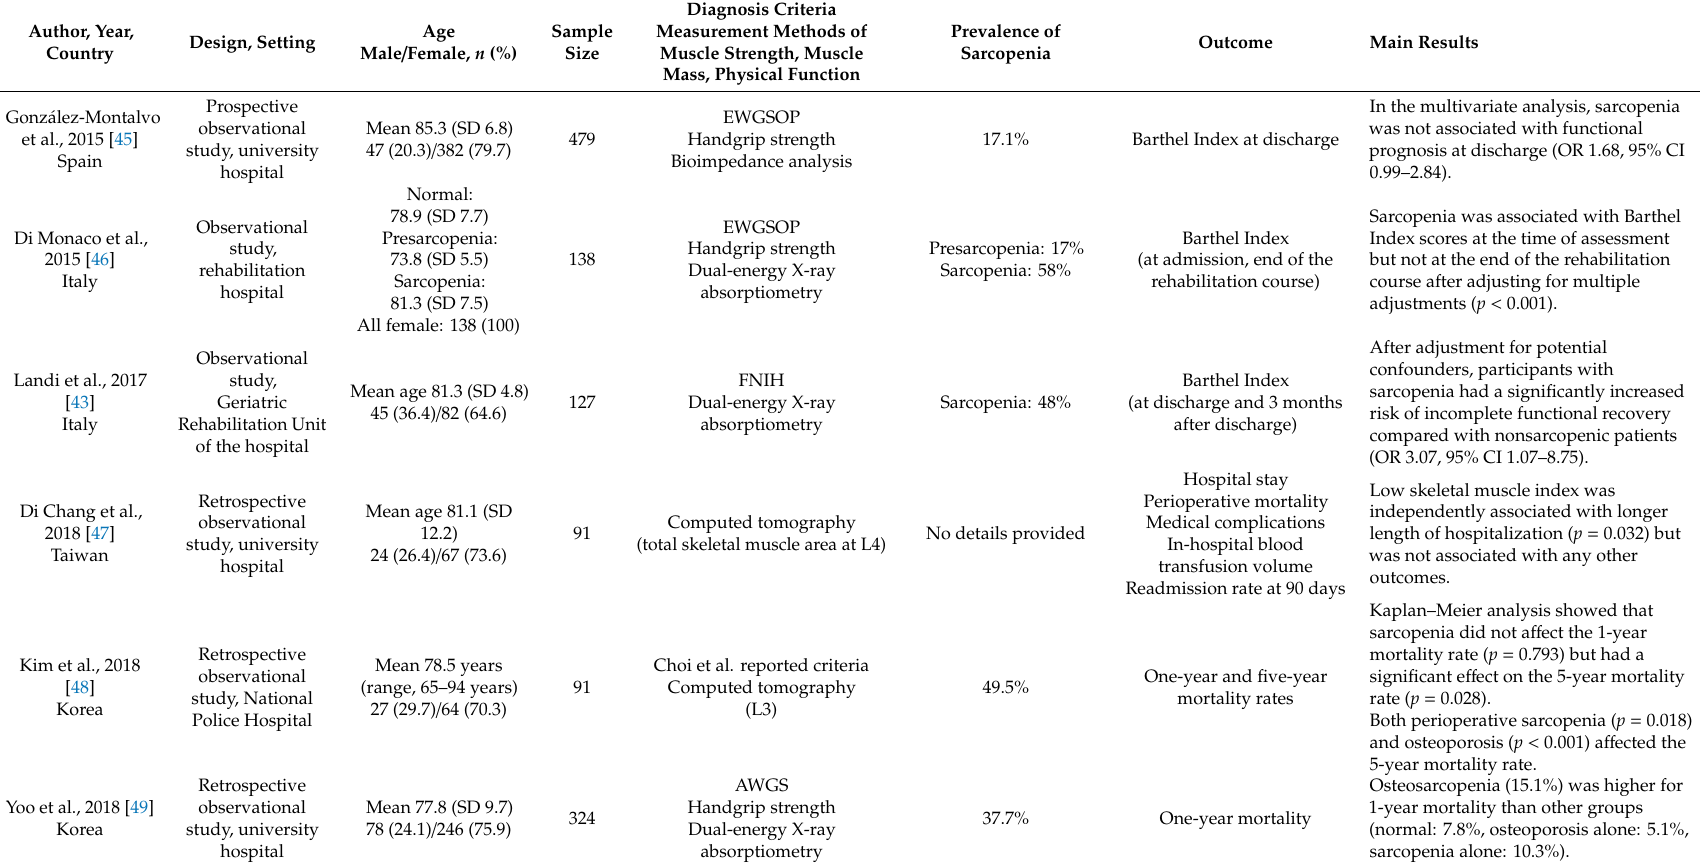
Table 2. Diagnosis criteria of sarcopenia, prevalence, and its impact on clinical outcomes in patients with hip